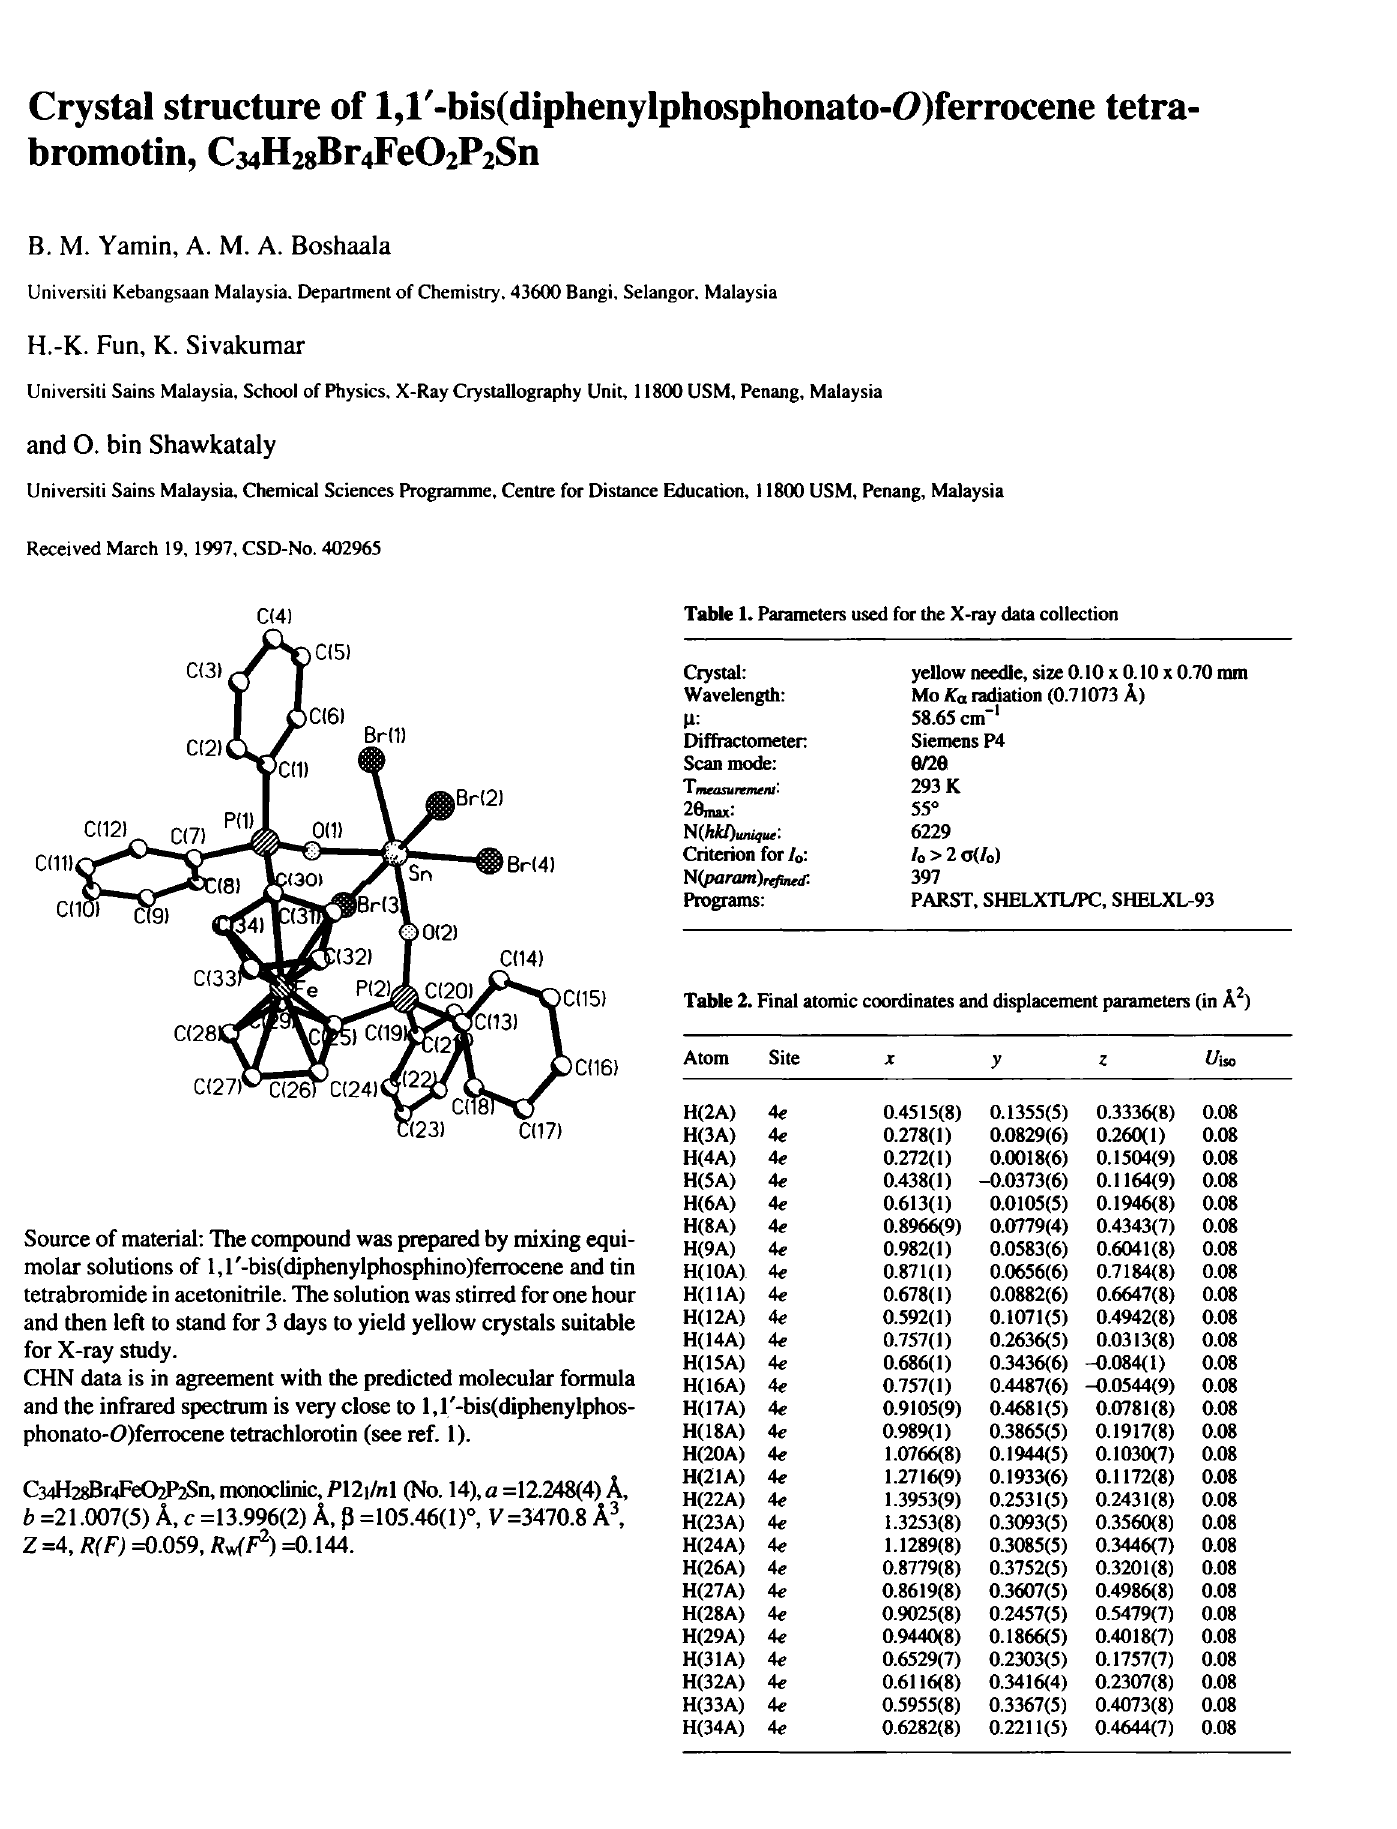
Table 1. Parameters used for the X-ray data collection